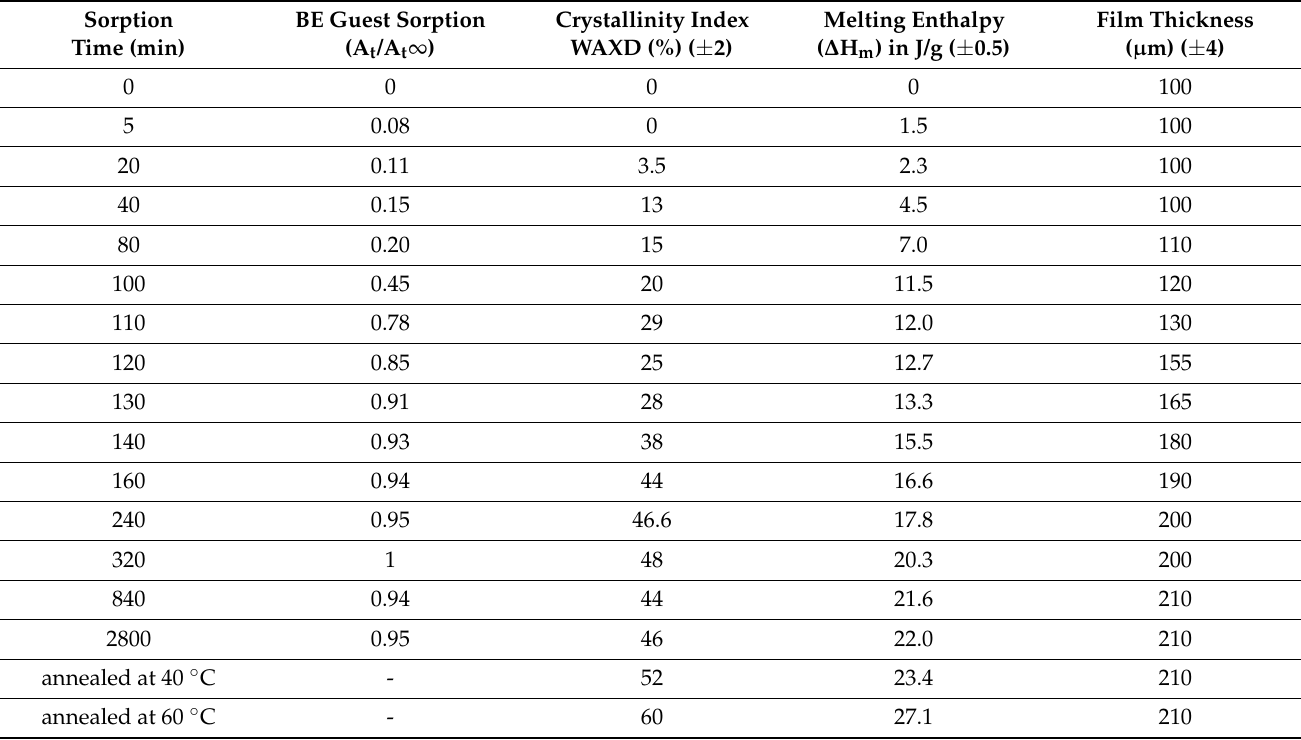
Figure 7. Crystallinity index ( χ c , from WAXD patterns) and melting enthalpy ( Δ H m , from DSC scans) of NC α form films, obtained by BE guest-induced crystallization of amorphous PPO films of dif- • ) 100 μ m; ( ) 150 μ m. The blue circles indicate 100 μ m films as crystallized after ferent thickness: ( 2800 min immersion in BE and subsequently annealed at 40 °C and 60 °C. The red line indicated the extrapolation to a fully crystalline α -form PPO sample.